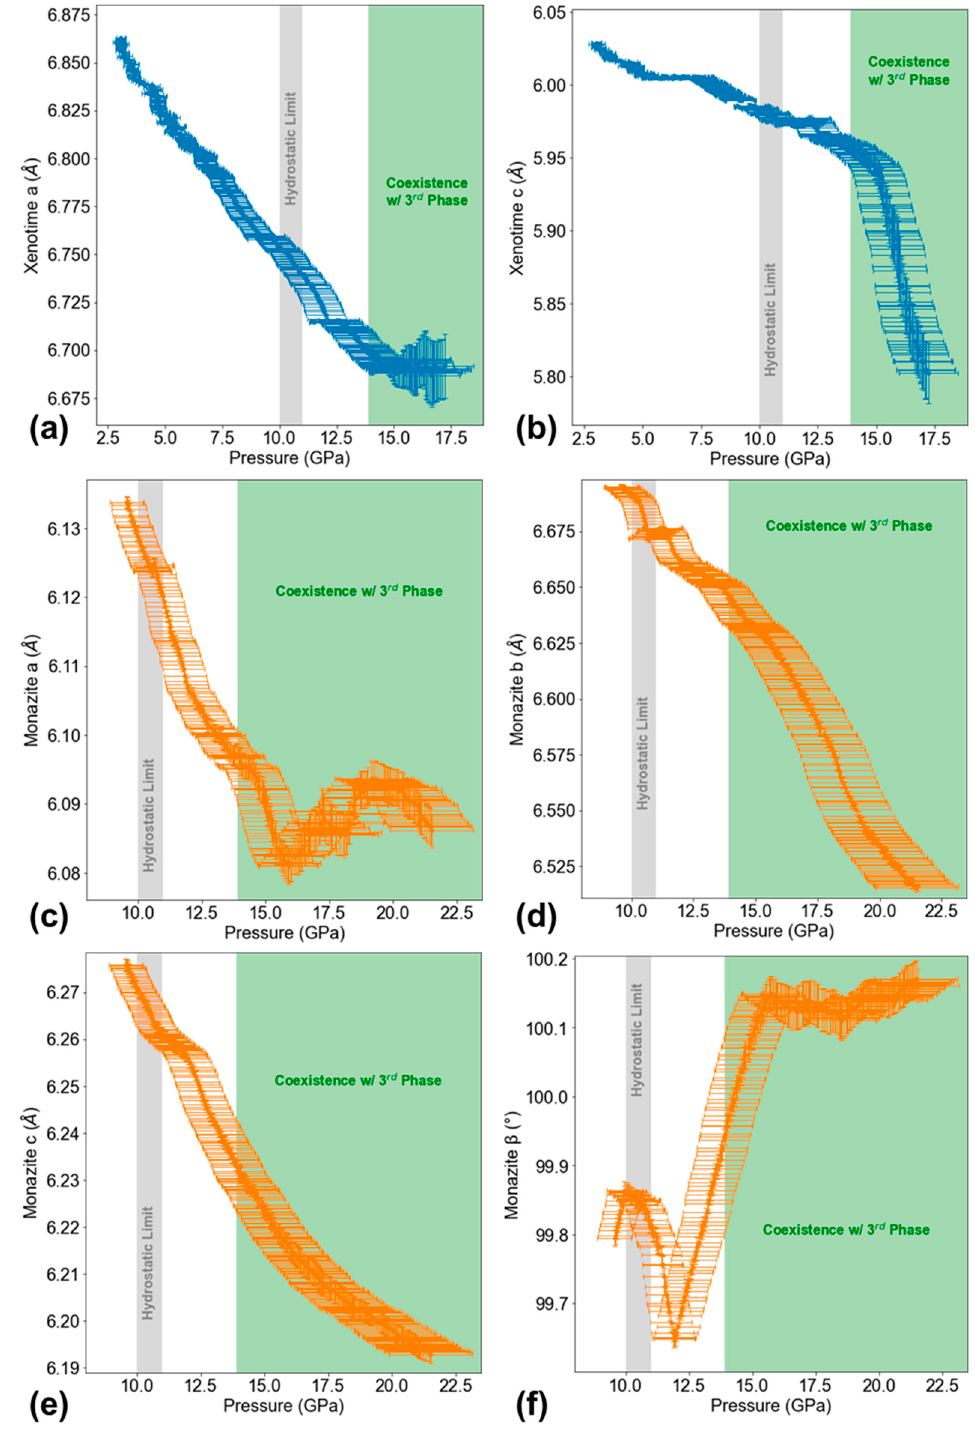
Figure 5. Pressure dependence of xenotime (x) and monazite (m) DyPO 4 lattice parameters. Green, shaded areas represent the pressure range in which a third (post-monazite) phase of DyPO 4 exists. The thin gray shaded area represents the hydrostatic limit of the pressure medium: ( a ) a x ; ( b ) c x ; ( c ) a m ; ( d ) b m ; ( e ) c m ; ( f ) β m . All parameters show some irregularity around the hydrostatic limit (10.5(5) GPa). The a x , c x , a m , and β m parameters exhibit notable changes in behavior after ~14 GPa.